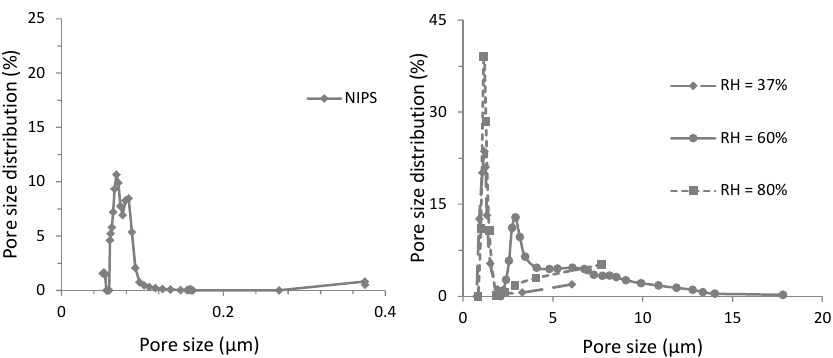
Figure 3. Pore size distributions (PSD) of membranes made via the NIPS ( left ) and VIPS ( right ) processes. Casting thickness: 500 µ m, polymer solution: 12% w / w PVDF.